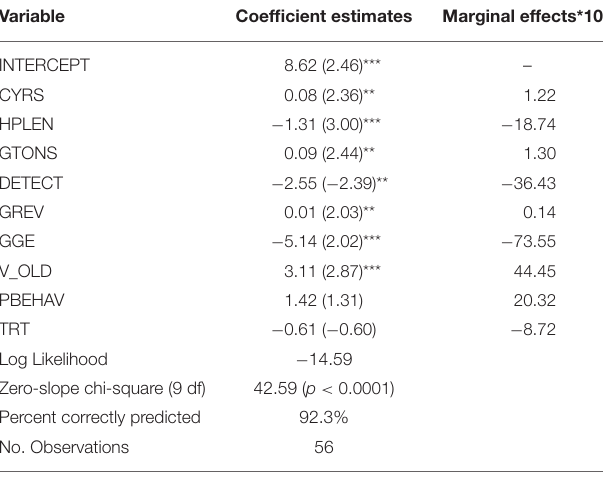
TABLE 3 | Factors of a vessel’s decision to violate pinger